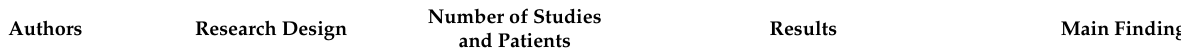
Table 2. Summary of recently published meta-analyses on the clinical use of